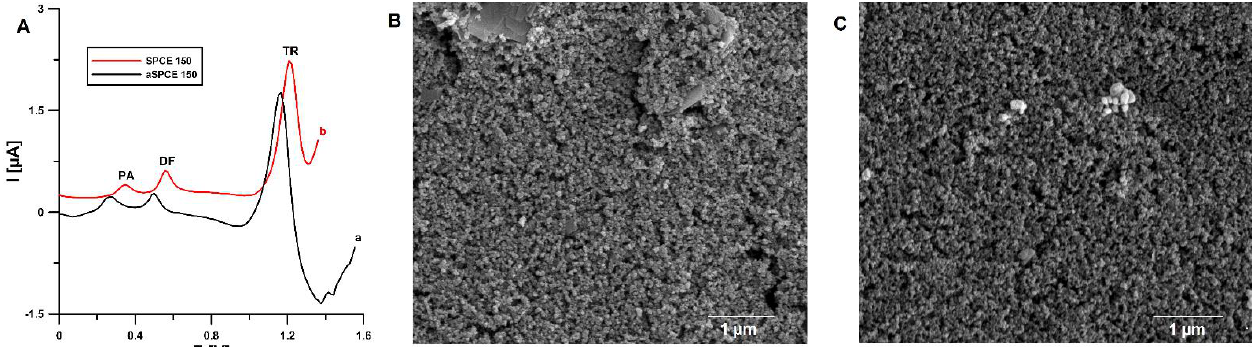
Figure 1. ( A ) Voltammograms of 2 × 10 − 6 mol L − 1 PA, 1 × 10 − 7 mol L − 1 DF, and 2 × 10 − 5 mol L − 1 TR in 0.1 mol L − 1 CH 3 COOH/CH 3 COONa buffer of pH 4.0 ± 0.1 recorded at the bare SPCE (a) and electrochemically activated SPCE (b). The DPAdSV parameters: E acc. of − 0.25 V, t acc. of 30 s, ΔE A of 50 mV, t m of 50 ms, and ν of 140 mV s −1 . SEM images with 25,000× magnification of bare SPCE ( B ) and aSPCE ( C ).